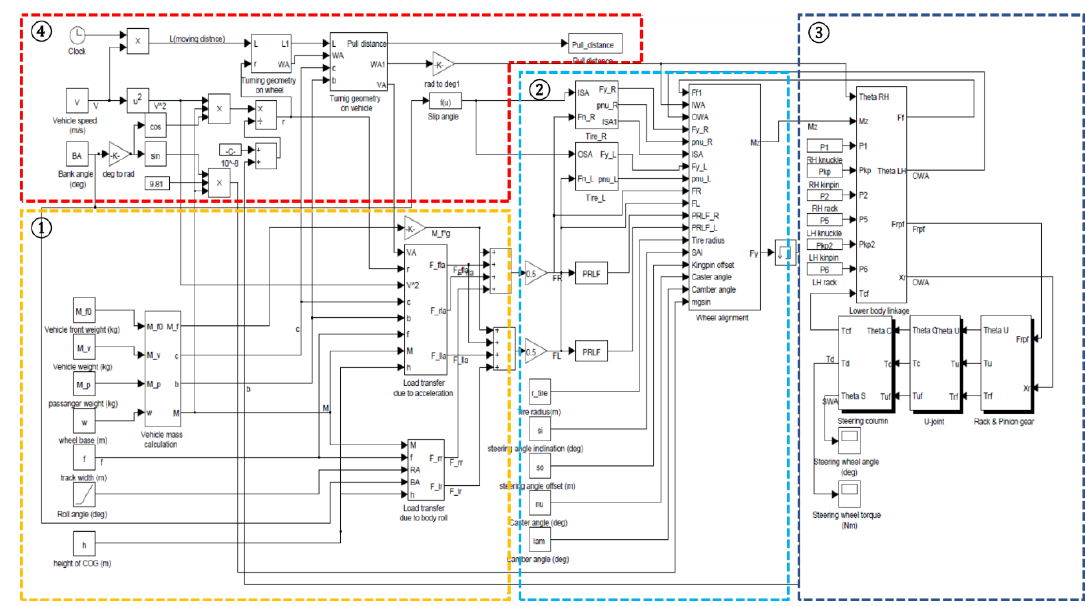
Figure 8. Developed steering pull model .